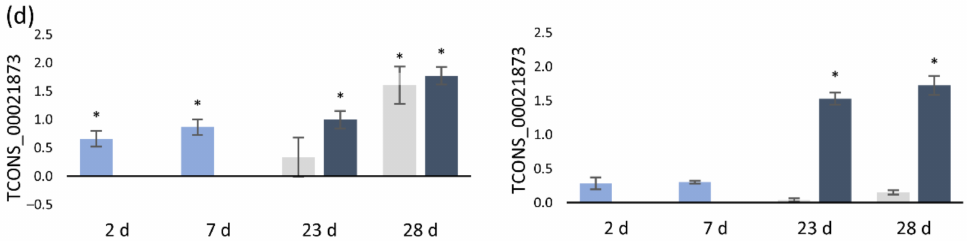
Figure 7. Expression profiles of four lncRNAs, i.e., TCONS_00014209 ( a ), TCONS_00019494 ( b ), TCONS_00032986 ( c ), and TCONS_00021873 ( d ) in WL-T and WL-S cucumber accessions under waterlogging stress. 1xH—non-primed plants, Rec—non-primed plants after 14-day recovery period, 2xH—primed plants. Data are expressed as the mean ± SD (standard deviation) of three independent biological replicates and three technical replications. Asterisks indicate a significant difference vs. control plants determined with Student t -test, p < 0.05.